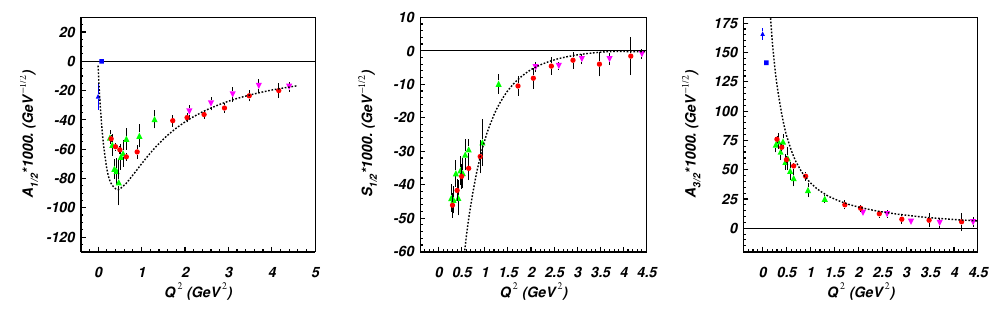
Figure 4. (Color online) CLAS results on the N (1520)3 / 2 − electrocouplings from analysis of the recent data on π + π − p electropro- duction [18, 19] (magenta filled triangles), from the analyses of N π electroproduction [32] (red filled circles), and from the previous CLAS data on π + π − p electroproduction [9, 21] (green filled circles). The results at the photon point are taken from PDG [29] (blue filled triangles) and from analysis of the CLAS N π photoproduction data [33] (blue filled squares) The results from the novel light front quark model [6, 11] are shown by the dashed lines.